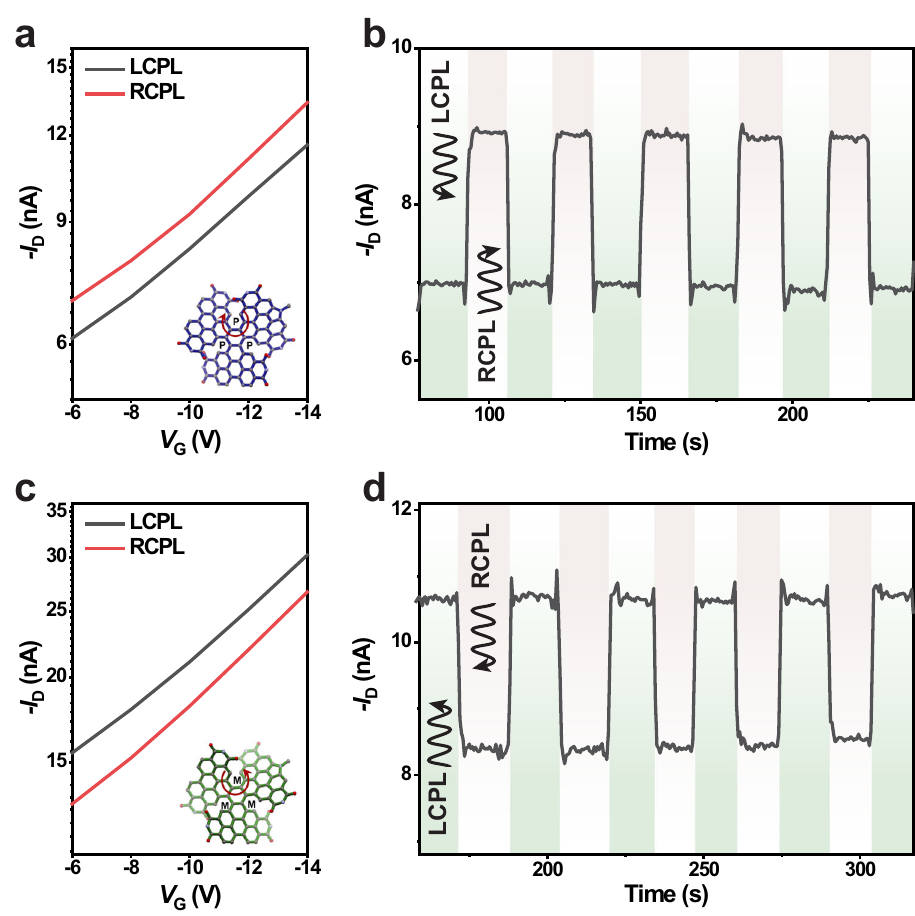
Fig. 2 Response of the photodetector to circularly polarized light. a , c Variation in the transfer characteristics of the photodetector based on 1- P /DPA crystal ( a ) and 1- M /DPA crystal ( c ) tested upon exposure to RCPL (red line) and LCPL (black line) illumination. b , d Real-time change in drain current I D in response to LCPL and RCPL illumination for the photodetector based on 1- P ( b ) and 1- M ( d ) started with the illumination of LCPL and changed during the test. I D was recorded at a constant drain and gate bias of V D = − 60 V and V G = − 10 V. The green shading and gray shading are tested with the illumination of LCPL and RCPL,